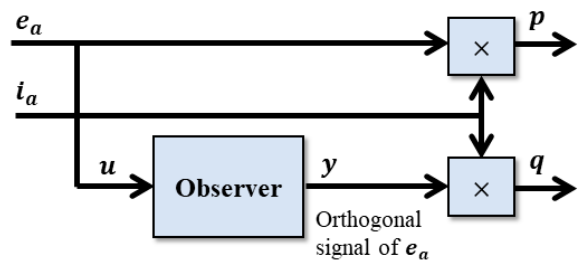
Figure 3. Power calculation by integration method. (cid:3505) 𝐴𝑠𝑖𝑛(𝜔𝑡)𝑑𝑡 = − 𝐴 𝜔 𝑐𝑜𝑠(𝜔𝑡)